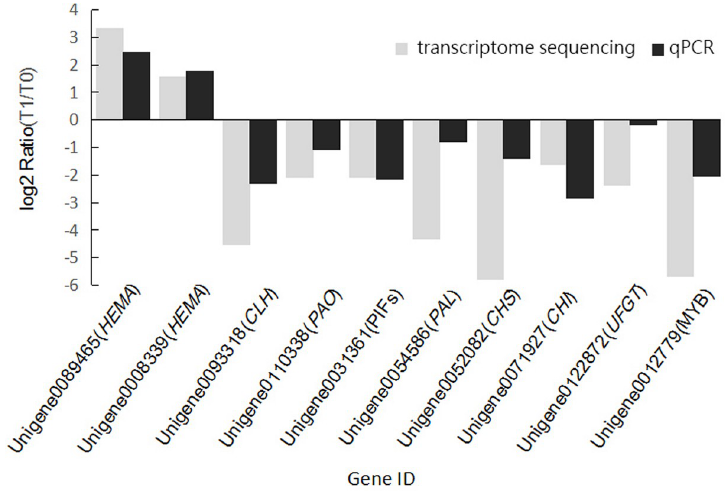
Fig 7. Real-time PCR validation of transcriptome sequencing results. The log2 Ratio(T1/T0) represents the relative gene expression.